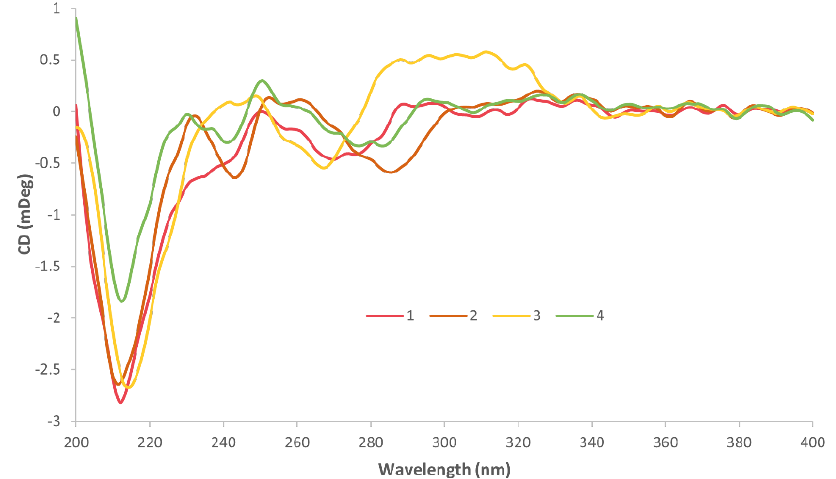
Figure 6. The CD spectra of 1 – 4 in water, over 50 accumulations.